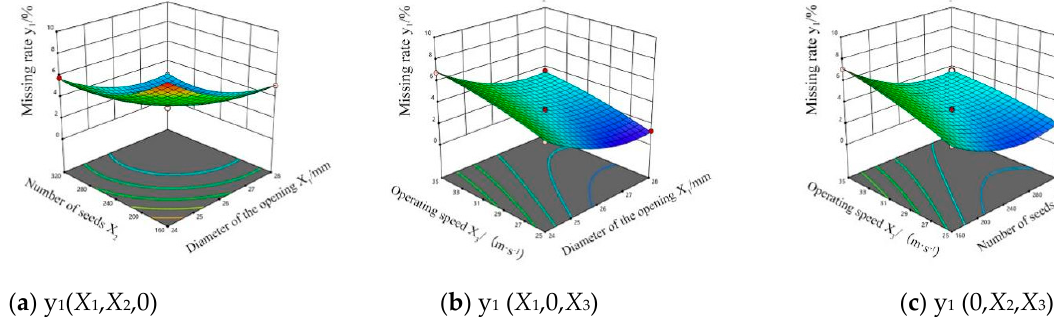
Figure 15. Effect of test factors on the missing rate.